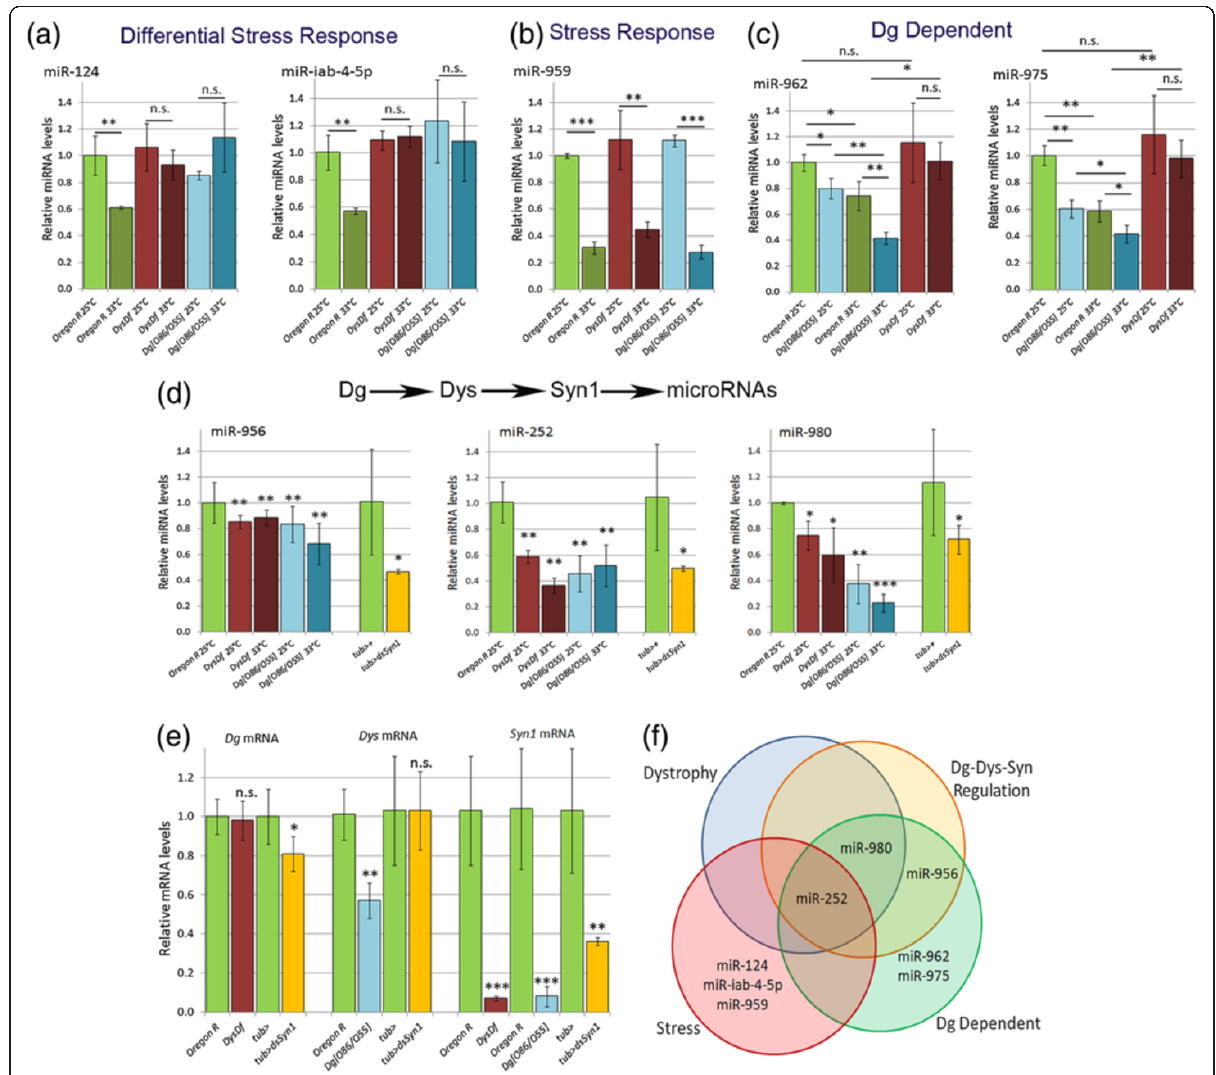
Figure 3 q-PCR of microarray data reveals miRNAs involved in stress response and associated with Dys and Dg signaling. q-PCR verification of microarray screen reveals miRNAs that fall into each functional category. ( a ) miR-124 and miR-iab-4-5p levels do not go down in Dys and Dg mutants when high temperature stress is applied. ( b ) miR-959 was found to be a general temperature stress response miRNA. ( c ) miR-962 and miR-975 have reduced levels in response to loss of Dg alone. ( d ) miR-956, miR-252 and miR-980 all are downregulated in response to loss of Dg, Dys and Syn1. ( e ) Relative levels of Dg mRNA in Dys and dsSyn1 mutants, Dys mRNA levels in Dg and dsSyn1 mutants and relative levels of Syn1 mRNA in Dys, Dg and dsSyn1 mutants. Each comparison is made to the closest control genotype ( Oregon R or tub-Gal4>+ ) to the left of the test genotype. Statistics were done using a one-tailed Student ’ s t-test: *P ≤ 0.05, **P ≤ 0.01, ***P ≤ 0.001, n.s – not significant. ( f ) Venn diagram shows overlap among verified miRNAs and the relevant functional